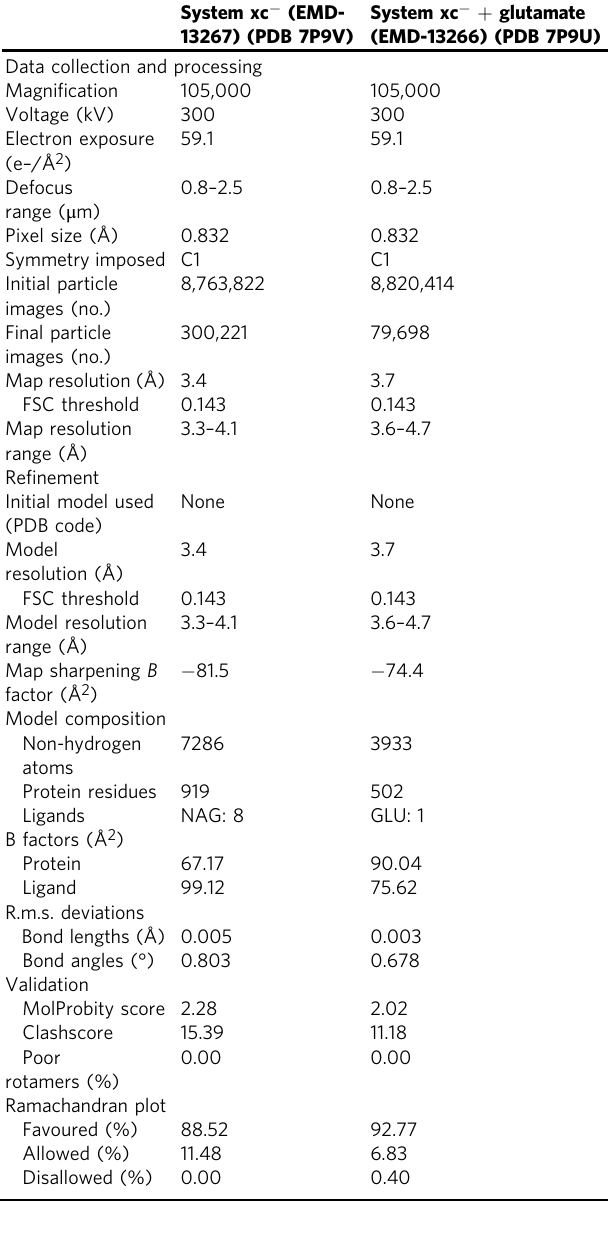
Table 1 Cryo-EM data collection, re fi nement and validation